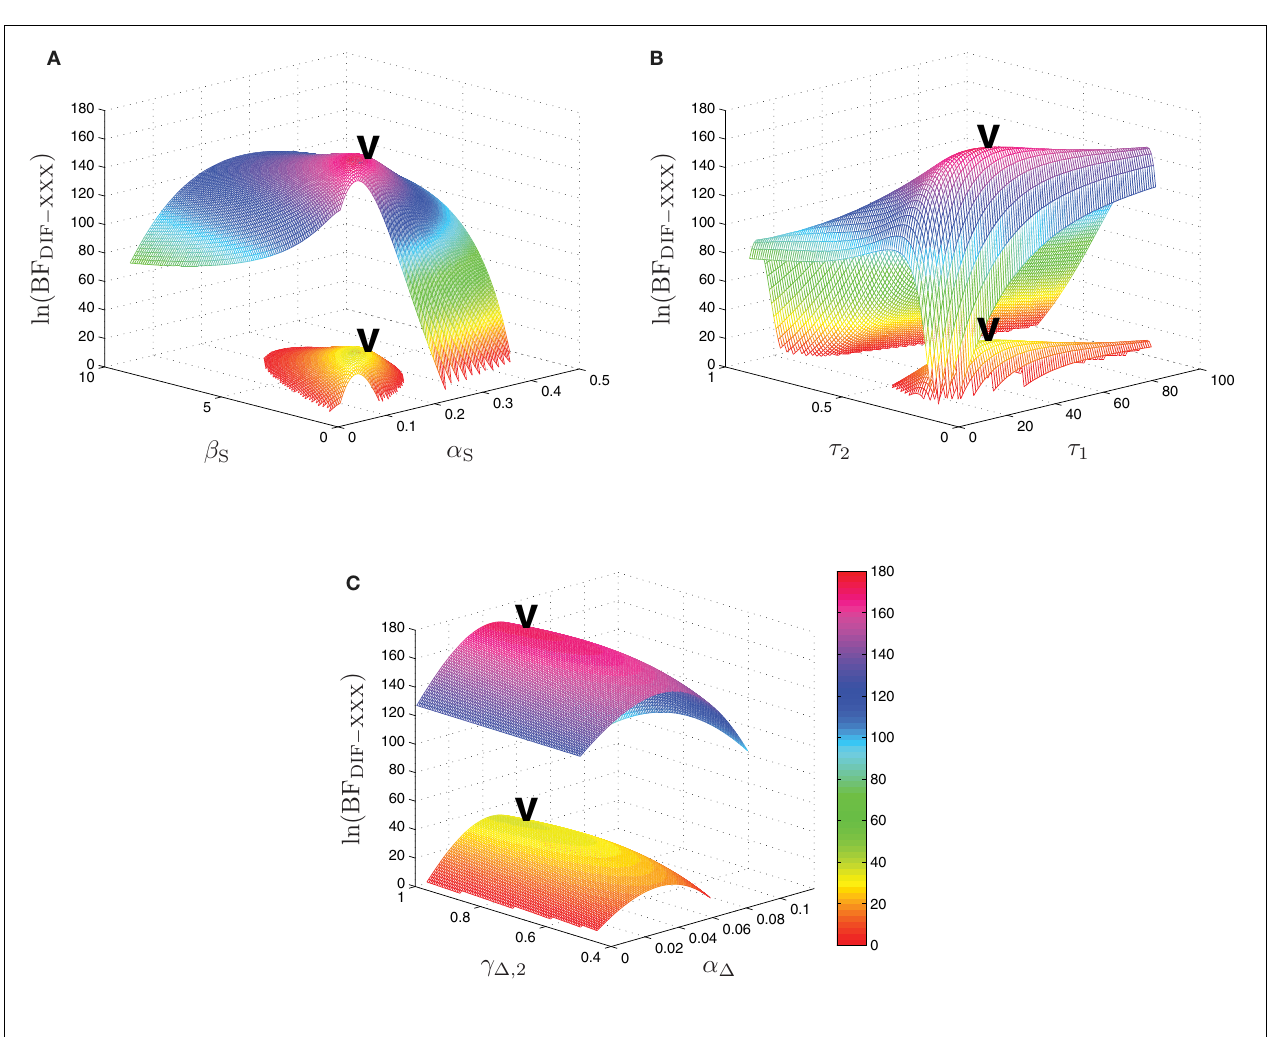
and α S . (B) Variation of the free long-term parameters τ 1 and τ 2 . In order to keep the lower contour visible, the log-Bayes factors for the 10 smallest values for τ 2 are not displayed. (C) Variation of the free alternation parameters γ α (cid:49) ,2 and (cid:49)